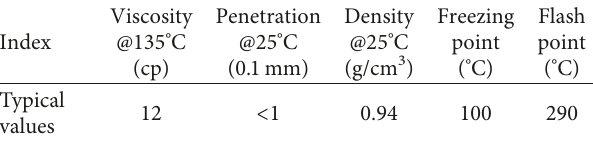
Table 3: Technical indexes of